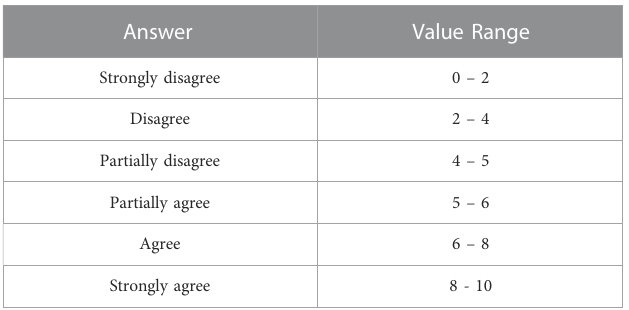
TABLE 4 Answer Range.